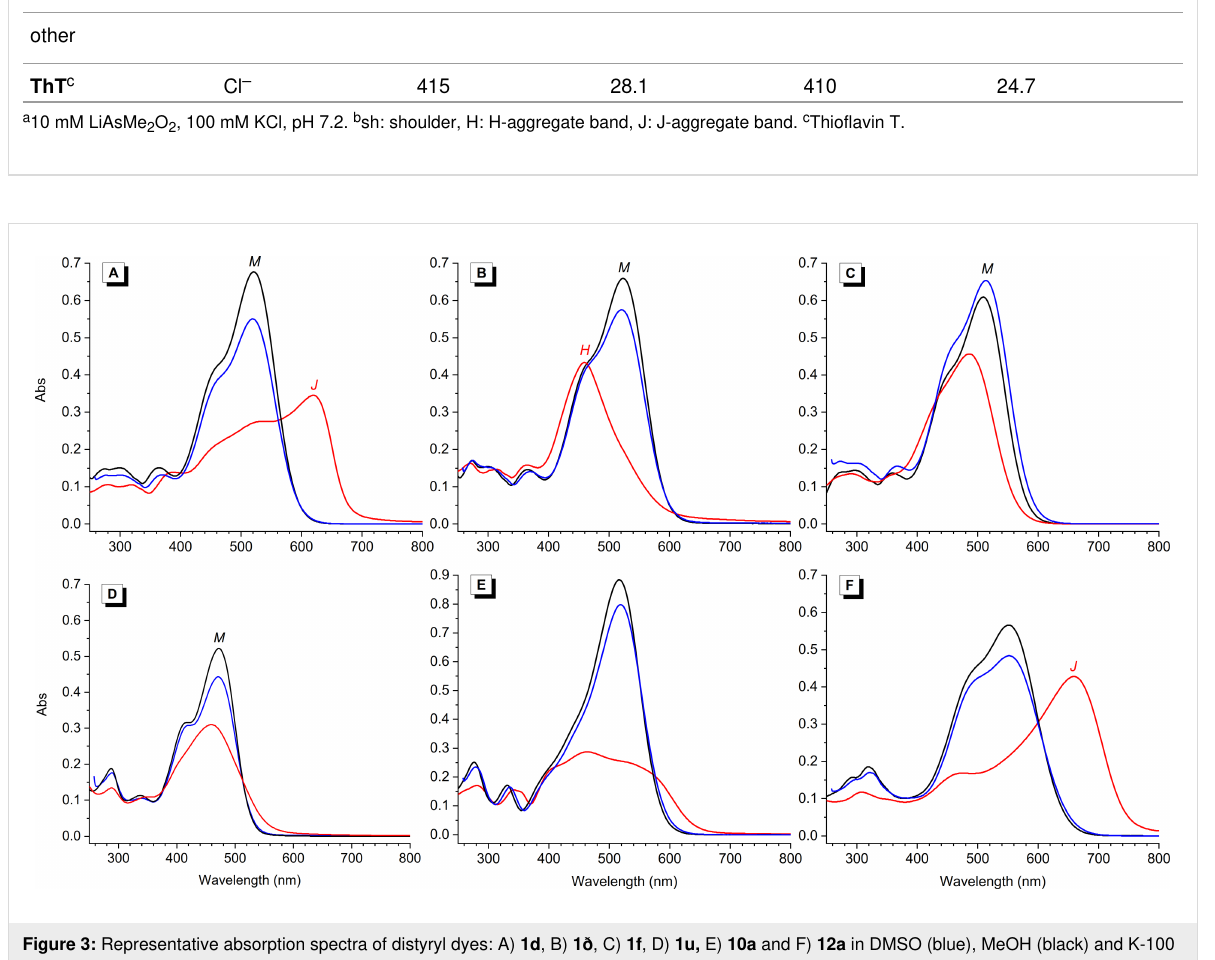
stituents ( 1g–1j ), the absorption spectra of the dyes are blue- shifted with respect to the prototype dye 1a . Conversely, strongly electron-donating ( 1b , 1d ) or π -extended ( 1k , 1Þ )